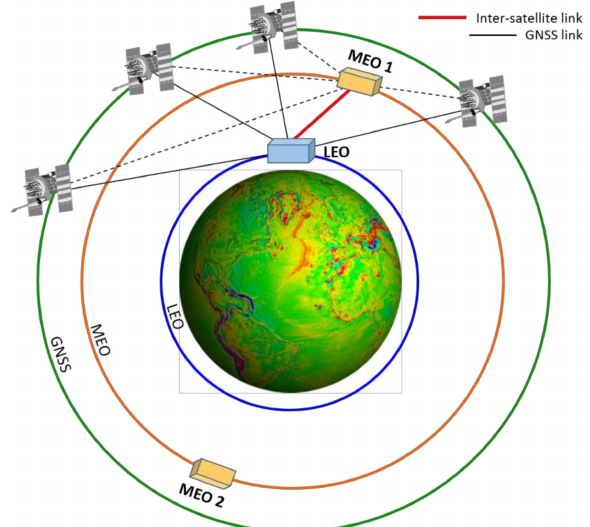
Figure 1. MOBILE mission constellation: high-precision inter-satellite links between LEO and MEOs (red), micro-wave links from GNSS satellites to MEOs and LEO